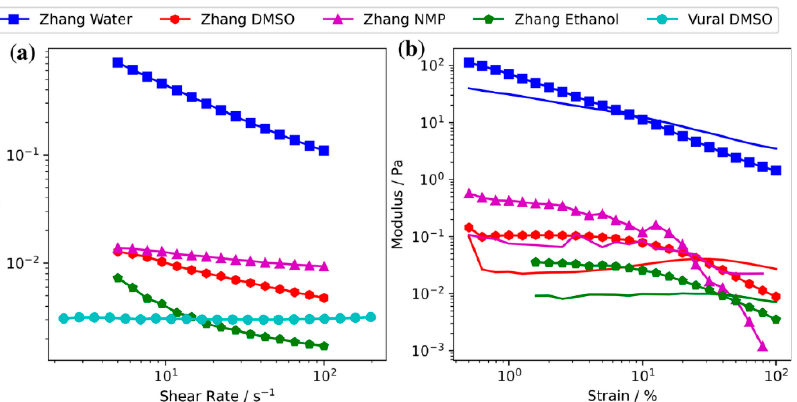
Figure 5. Comparison of rheological behavior of Ti 3 C 2 T x MXene-based inks reported by Zhang et al. and Vural et al. ( a ) Viscosity vs. shear rate. ( b ) Loss and elastic moduli vs. oscillatory strain amplitude ( G ′′ without markers and G ′ with markers). The amounts of Ti 3 C 2 T x MXene in water, ethanol and NMP are respectively 36, 0.7, and 12 mg mL − 1 . 12 mg mL − 1 and 2.25 mg mL − 1 are the Ti 3 C 2 T x concentrations in DMSO, respectively, used by Zhang et al. and Vural et al.